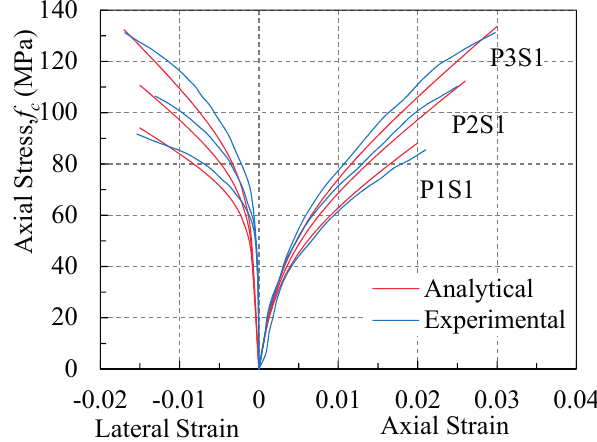
Figure 20. Comparison of compressive stress–strain curves between the predictions and test results for Specimens P1S1, P2S1, and P3S1.